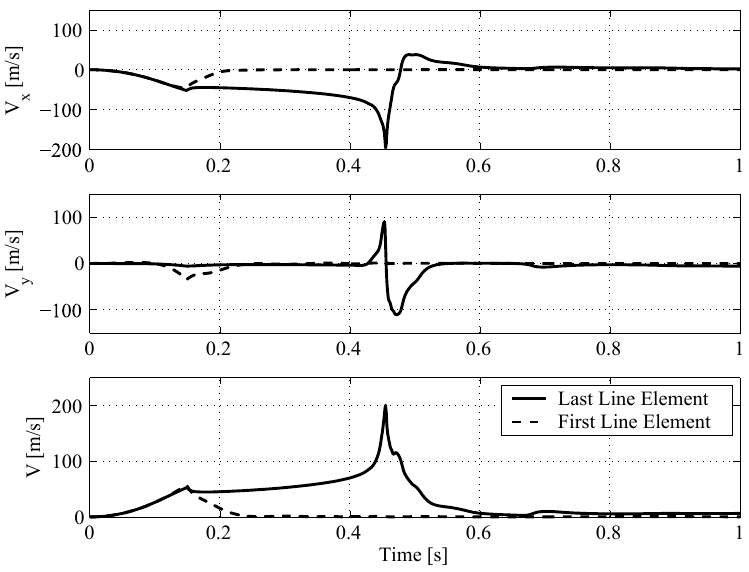
Fig. 12. Fly line fi rst/last element velocity time history during a cast [Rigid Rod